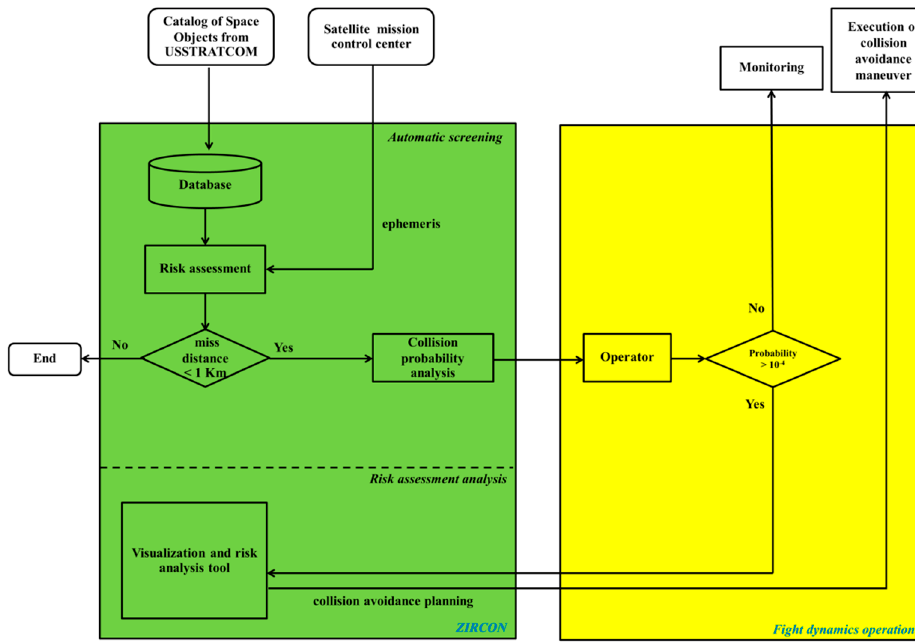
Figure 1. Space traffic management system process: ZIRCON.